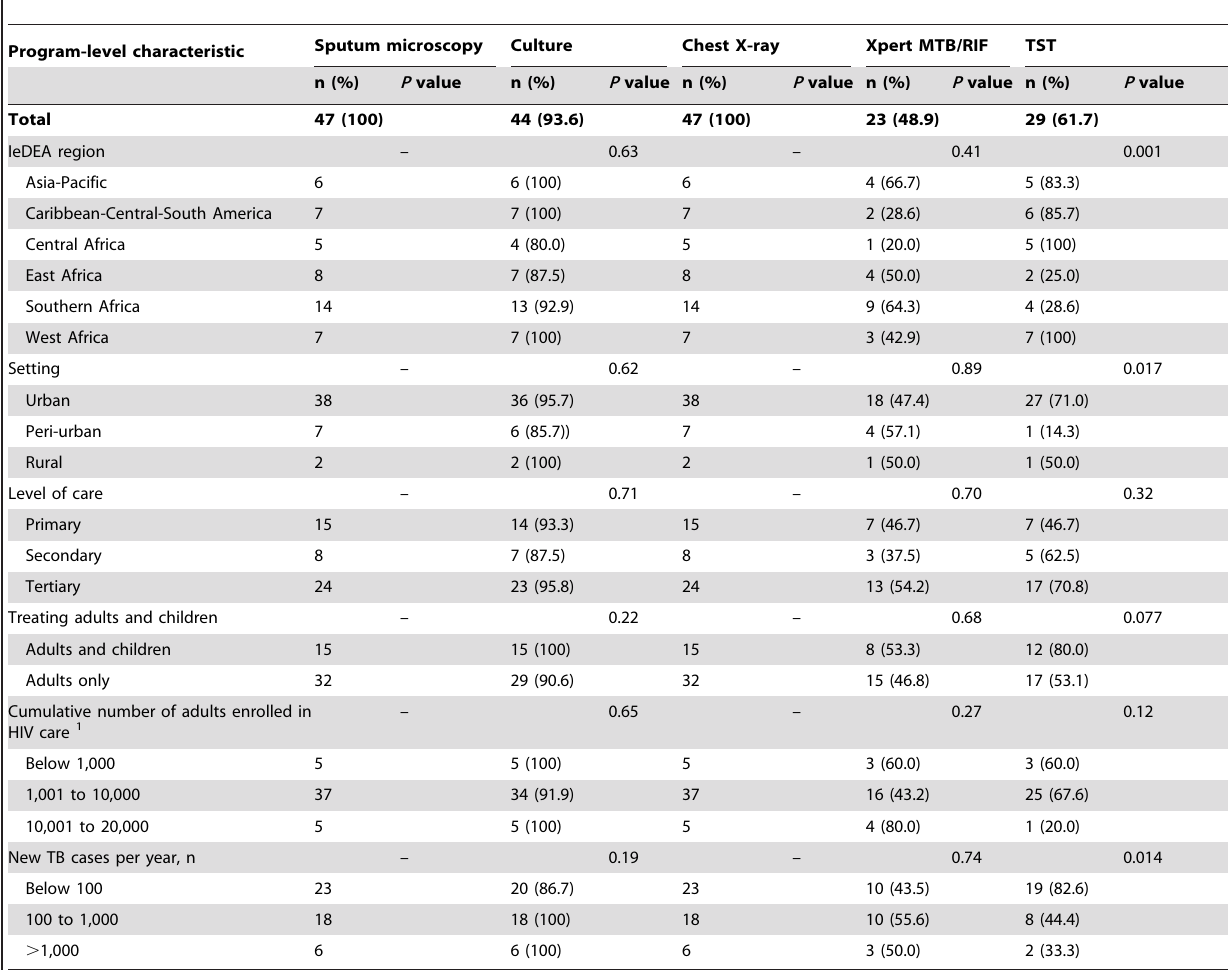
Table 2. Program-level characteristics associated with the availability of sputum smear microscopy, culture, chest X-ray, Xpert MTB/RIF, and tuberculin skin testing (TST) in 47 ART programs treating adults in lower income